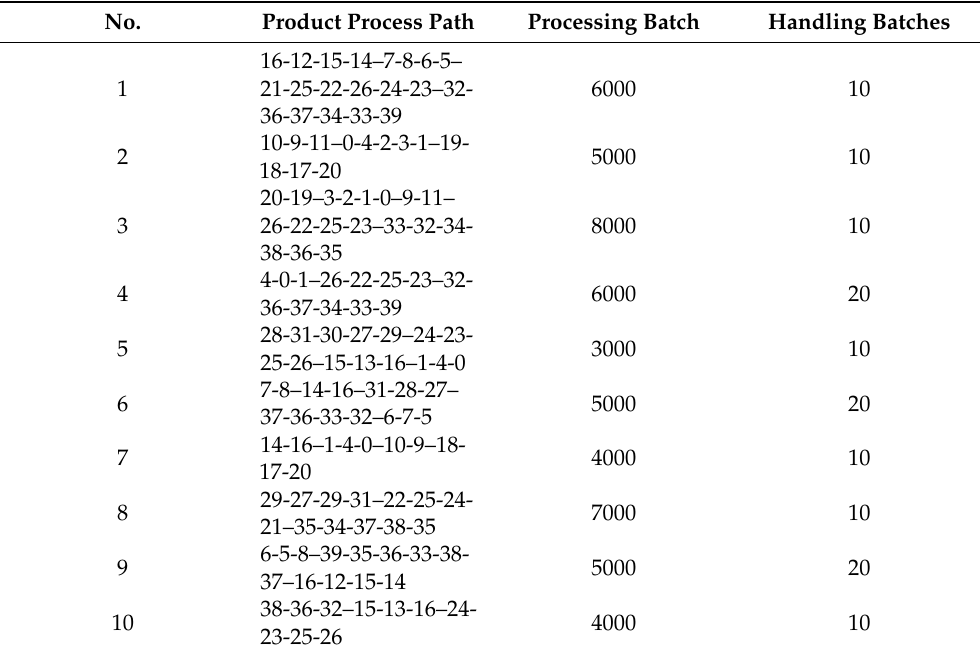
Table 2. Product information.